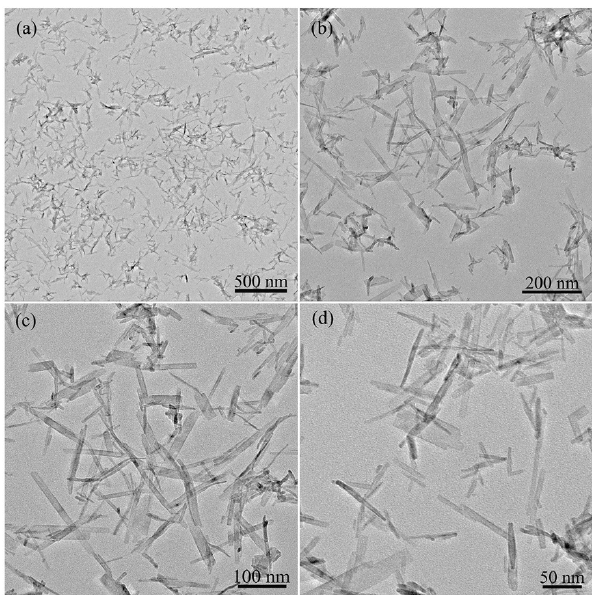
Fig. 1 TEM images of as-prepared CuO nanobelts with different magnification: (a) 10,000×, (b) 30,000×, (c) 50,000×, and (d) 80,000×.